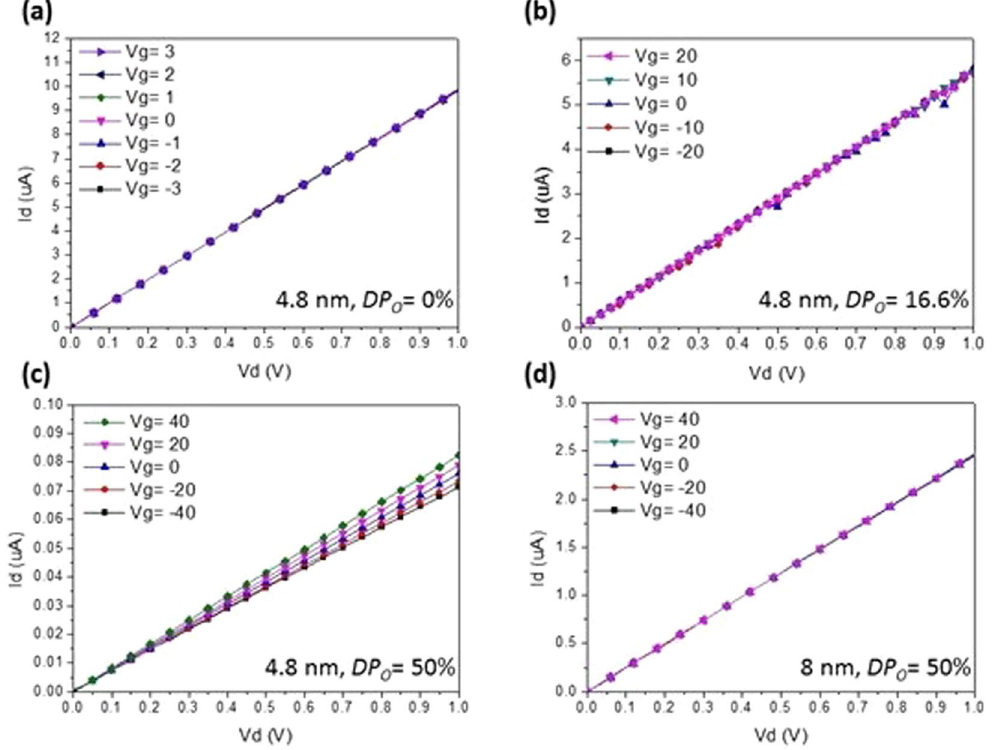
Figure 3. Room-temperature I d - V d characteristics at various bottom gate voltages ( V g ) of metallic channel transistors with the oxygen-doped TiN ultrathin-body channel. ( a ) 4.8 nm TiN-based channel with the nominal oxygen doping percentage ( DP O ) of 0%. ( b ) 4.8 nm TiN-based channel with the DP O of 16.6%. ( c ) 4.8 nm TiN- based channel with the DP